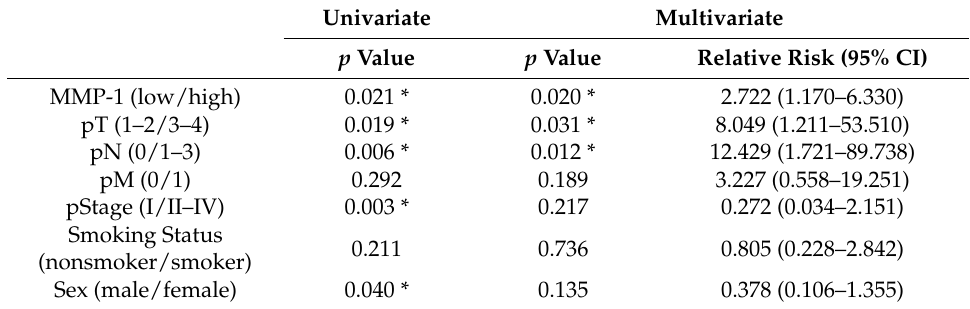
Table 3. Uni- and multivariate analyses of overall survival in patients with lung adenocarcinoma ( n =